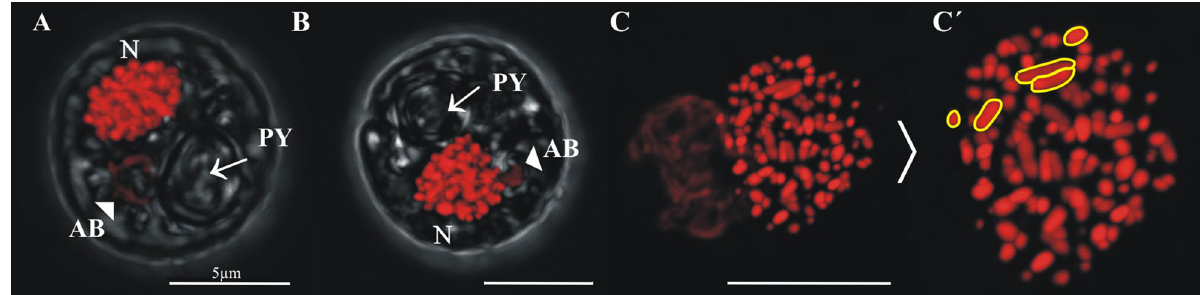
Figure 4. Confocal images of cells sorted in the 1C DNA content gate. ( A , B ) representative images of cells showing the pyrenoid (PY, arrow), accumulation body (AB, arrowhead) and nucleus (N). ( C , C ′ ) Images of a nucleus showing individualized chromosomes with varied shapes and sizes ( C ′ ) examples of individual chromosomes are outlined in